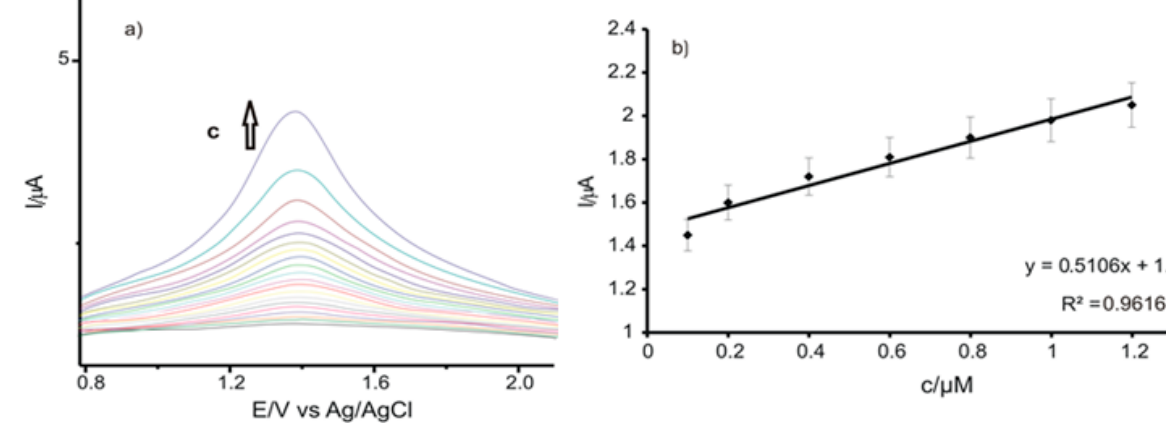
Figure 7. ( a ) Zoomed-in view of the anodic peak zone of the CVs registered with GPH-GNP-SPE immersed in CGA solutions with the concentrations in the range 0.1–1.20 µ M; ( b ) linear dependence between the anodic peak current and the concentration of the CGA solution.